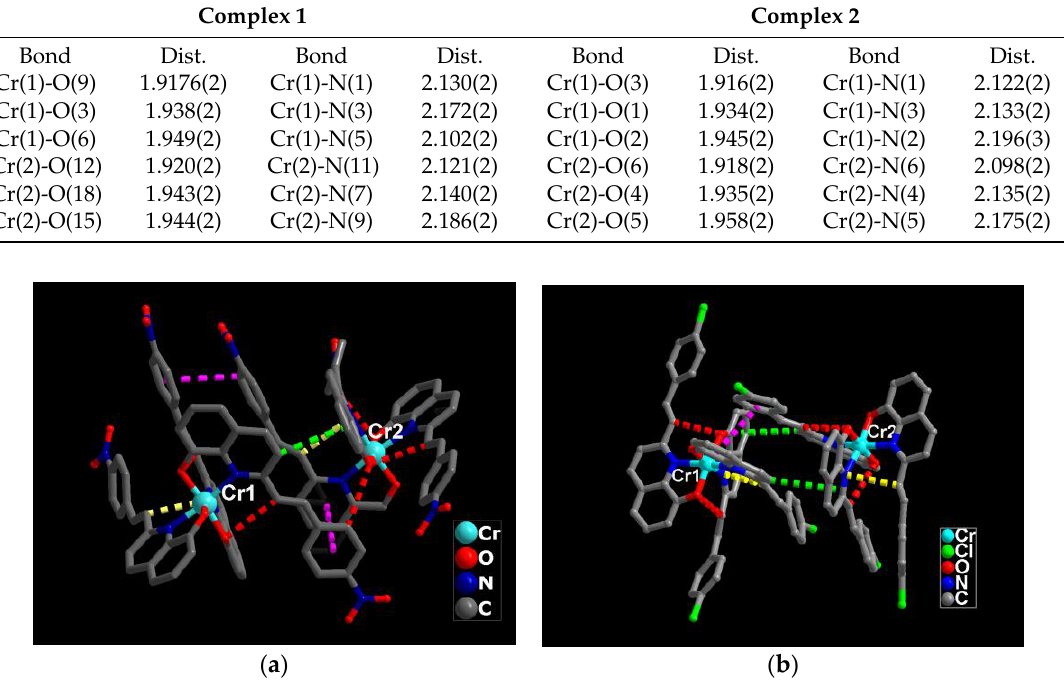
Figure 1. Electron paramagnetic resonance (EPR) spectra of the crystalline samples of complex 1 and 2 at room temperature and v = 9.07 GHz. Broad intense transitions are observed at 168 and 162 mT resonance fields, respectively.